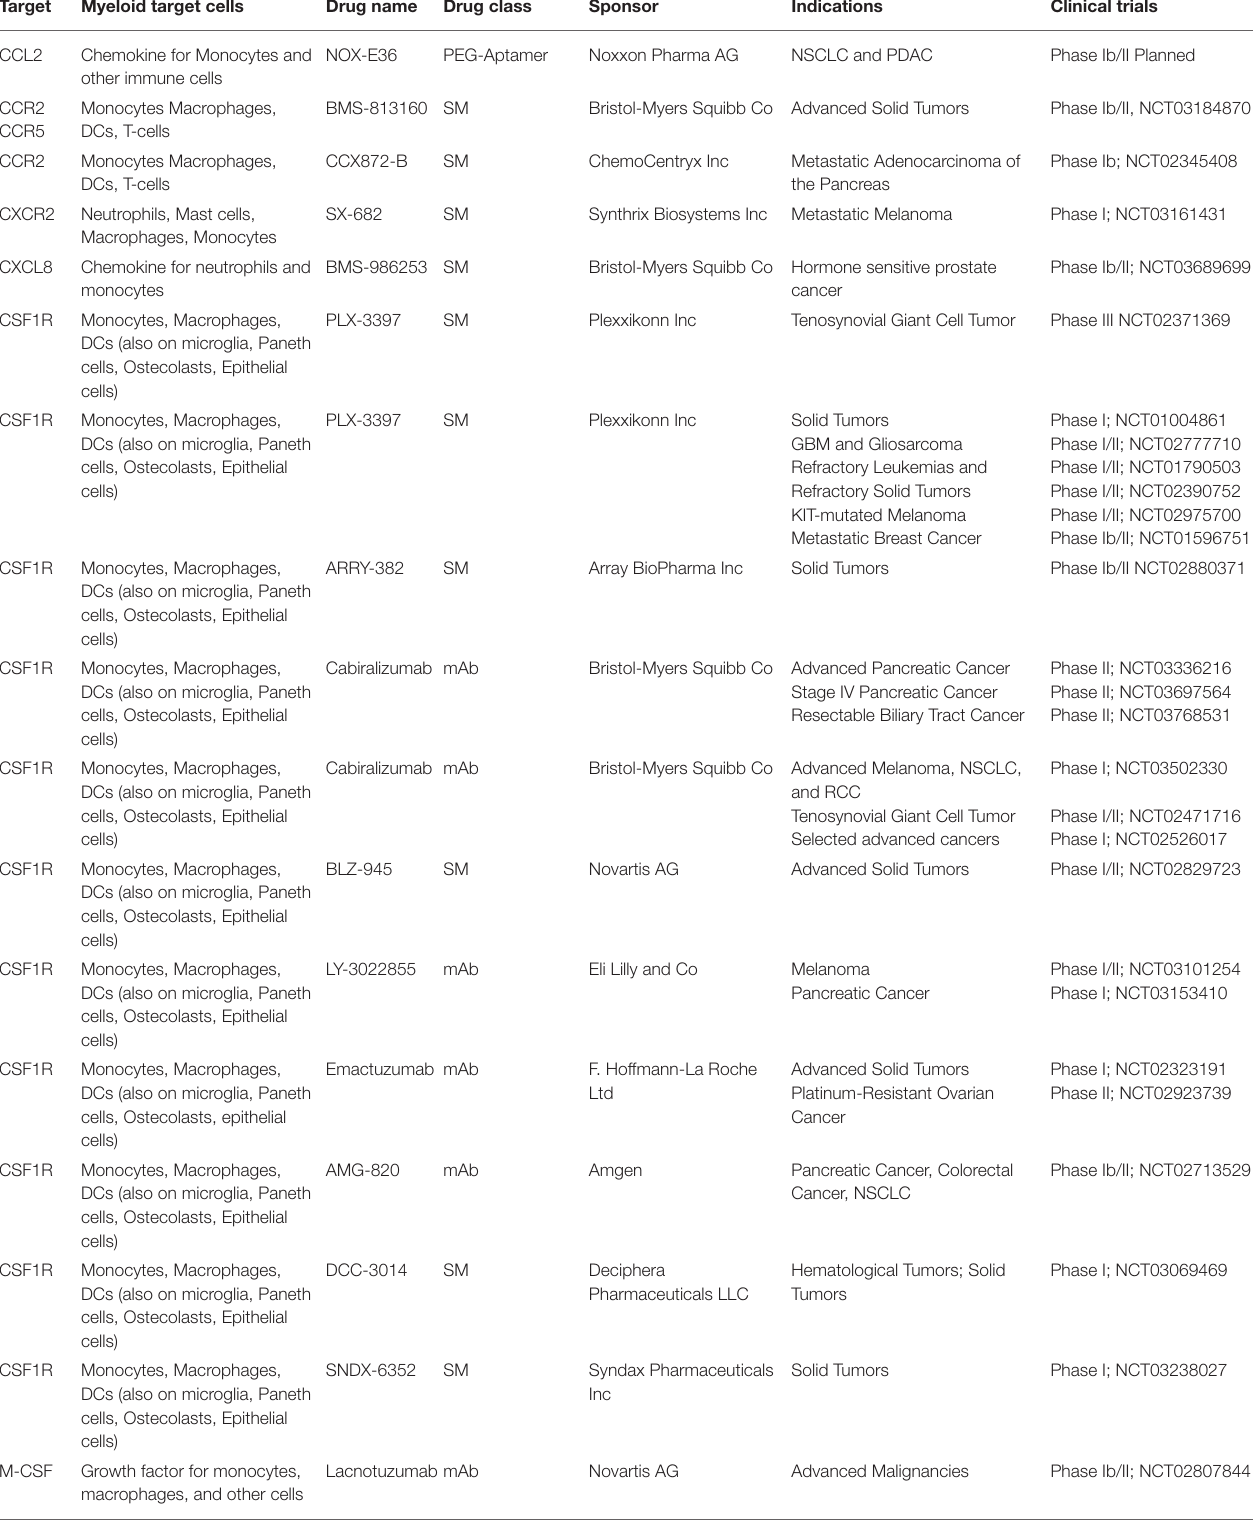
TABLE 1 | Summary of ongoing clinical trials with agents that target myeloid cells.